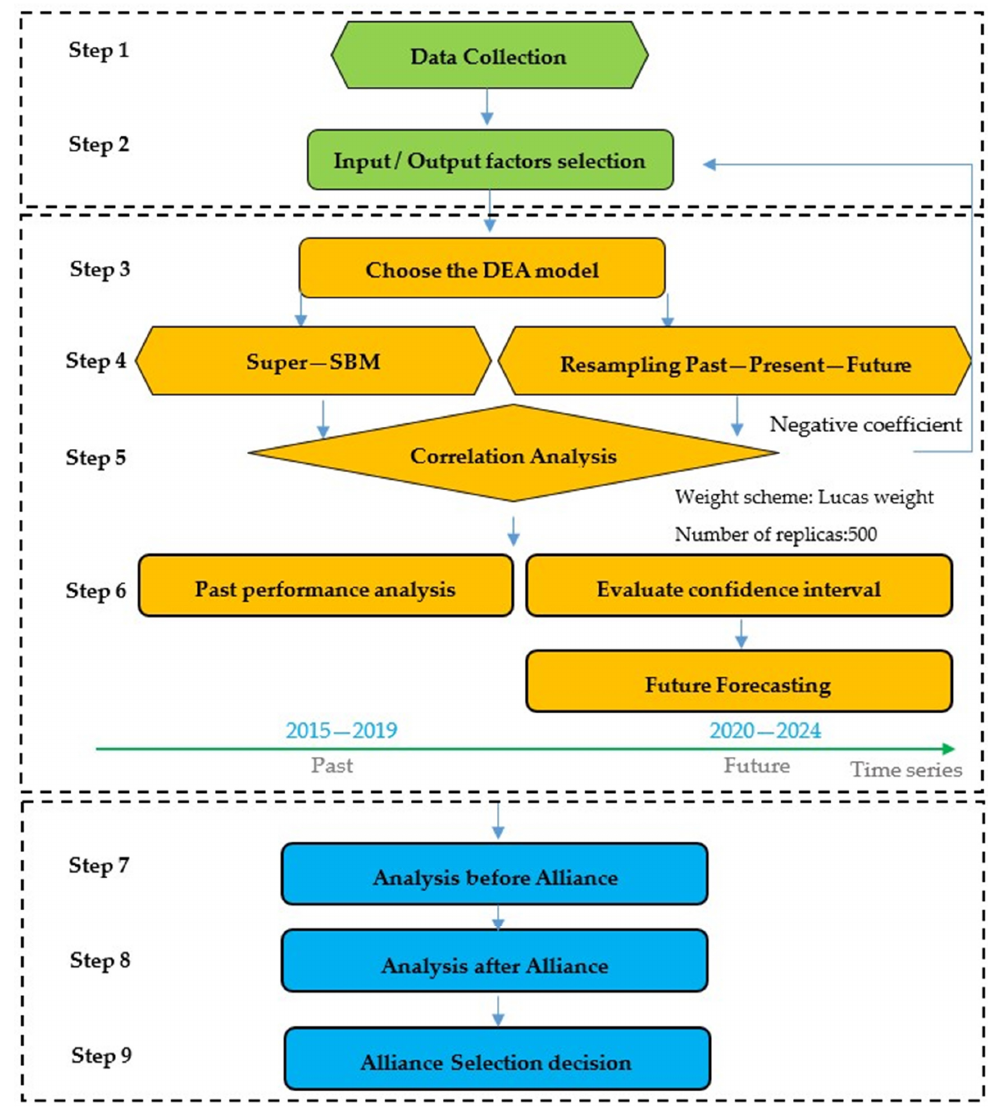
Figure 1. Research development.